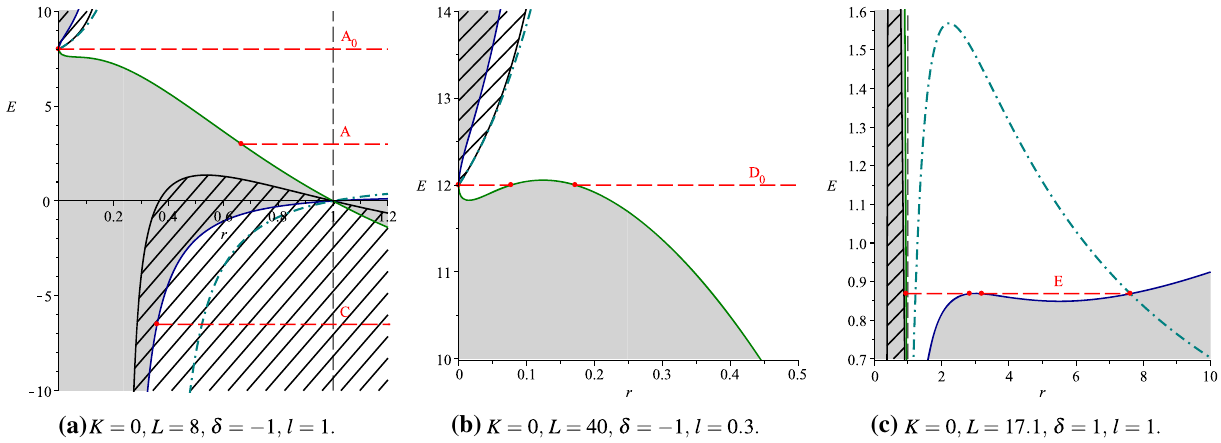
Fig. 5 a , b Effective potential V ± of the r motion for δ = − 1 with parameters chosen to allow for terminating orbits of type A 0 and D 0 (see Table 1). c Effective potential V ± of the r motion with parameters